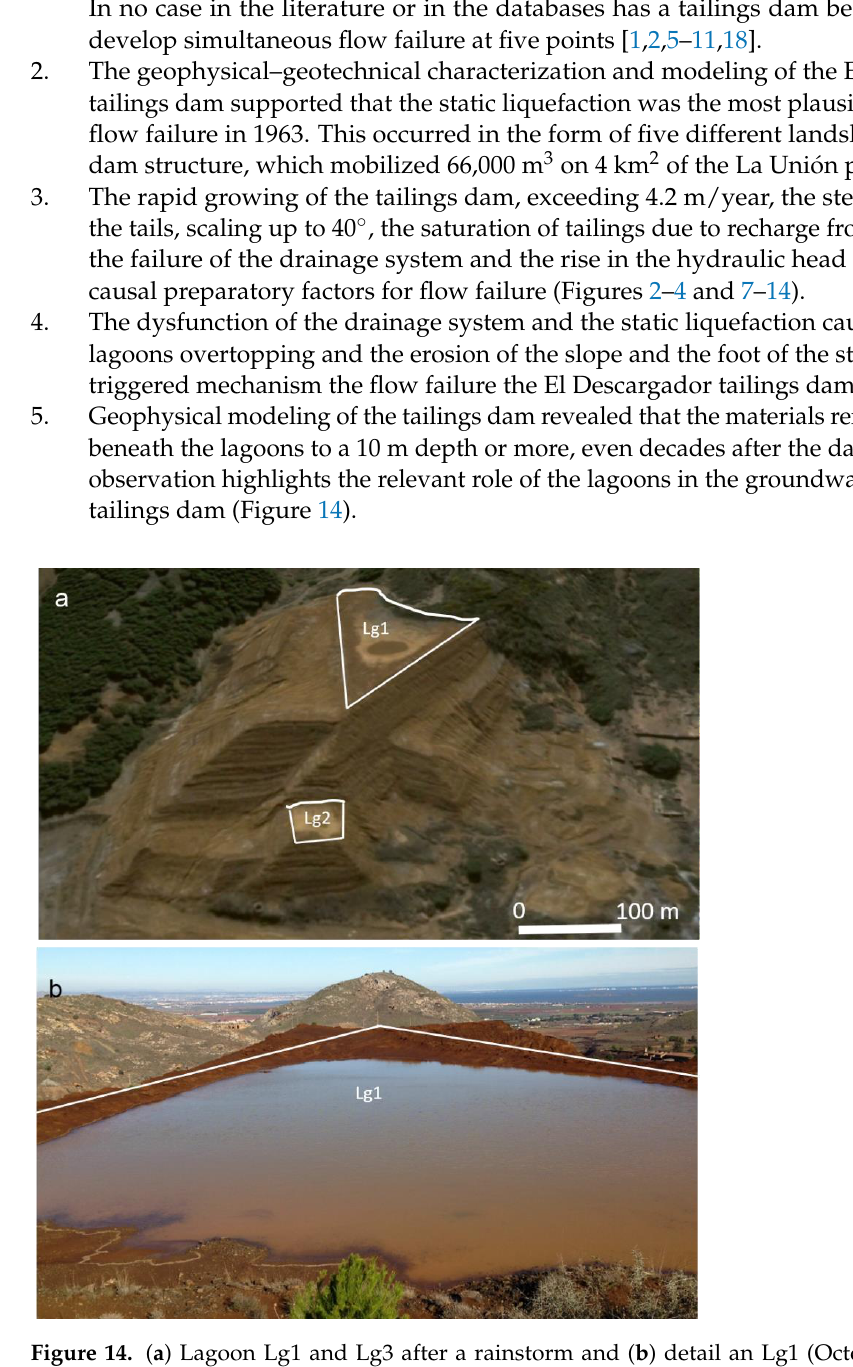
Figure 14. ( a ) Lagoon Lg1 and Lg3 after a rainstorm and ( b ) detail an Lg1 (October 2015). The spatio-temporal evolution of drying and wetting of the lagoons can be seen in the Google Earth clock (Since June